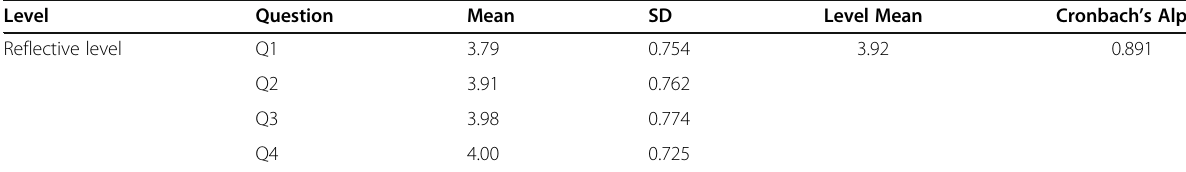
Table 4 Analysis results of the respondents ’ reflective-level experience